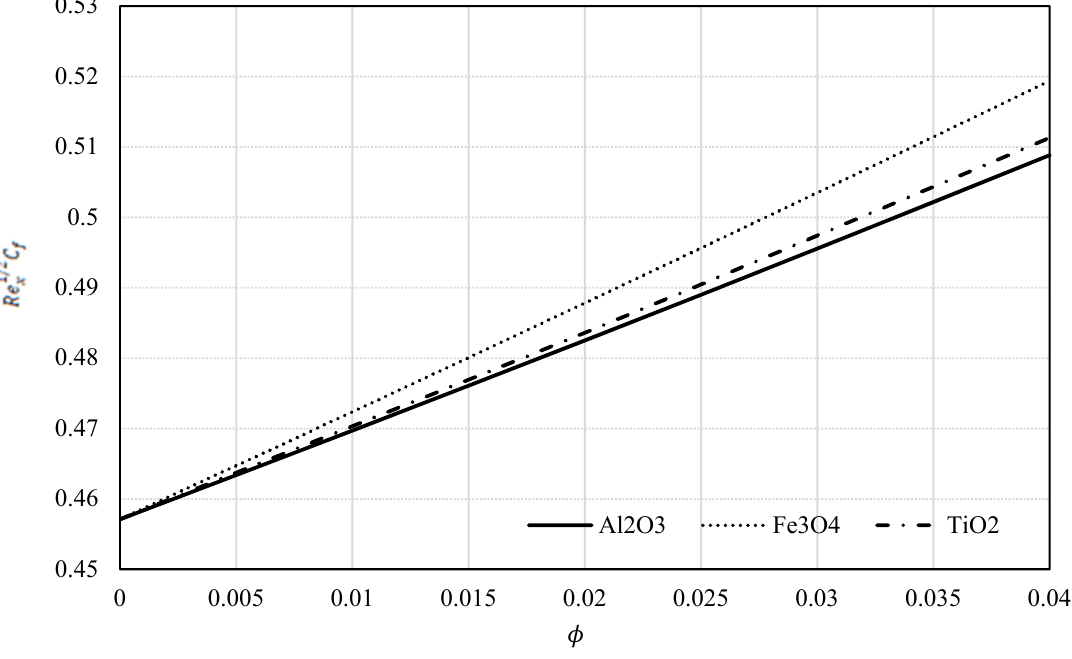
Figure 13. Re 1/2 x C f versus φ for all three Figure 13. 𝑅𝑒 (cid:3051)(cid:2869)/(cid:2870) 𝐶 (cid:3033) versus 𝜙 for all three nanofluids. Figure 13. 𝑅𝑒 (cid:3051)(cid:2869)/(cid:2870) 𝐶 (cid:3033) versus 𝜙 for all three nanofluids.